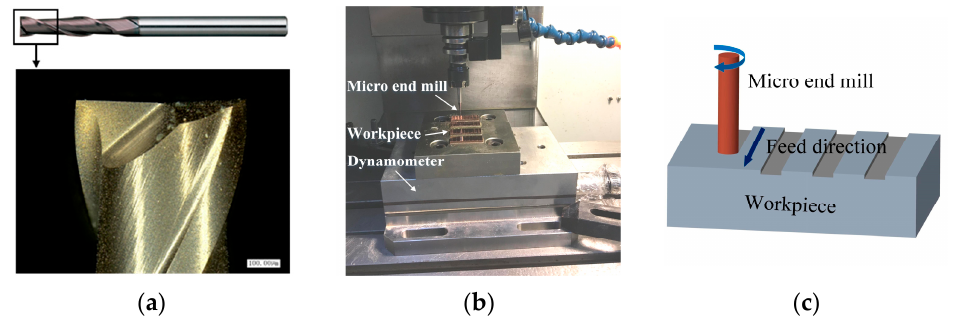
Figure 1. Micro end mill and micro milling experiment. ( a ) Micro end mill. ( b ) Micro milling experiment. ( c ) Schematic of full slot milling.